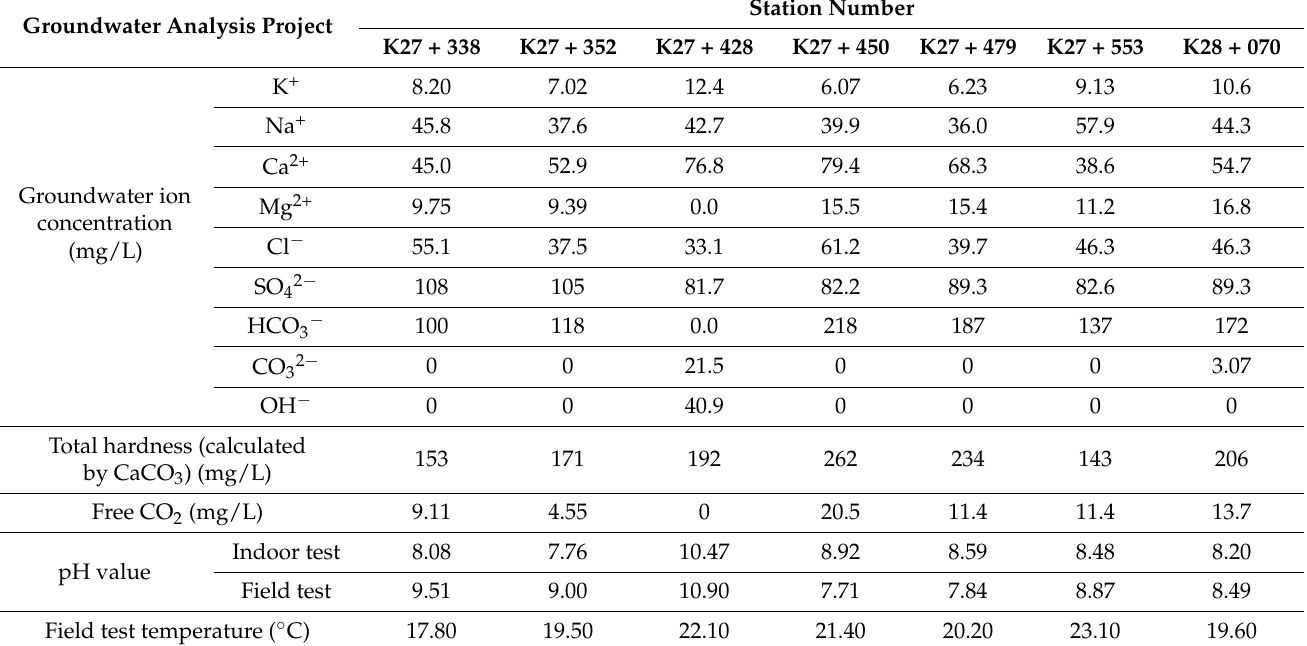
Table 2. Statistics of groundwater test and analysis